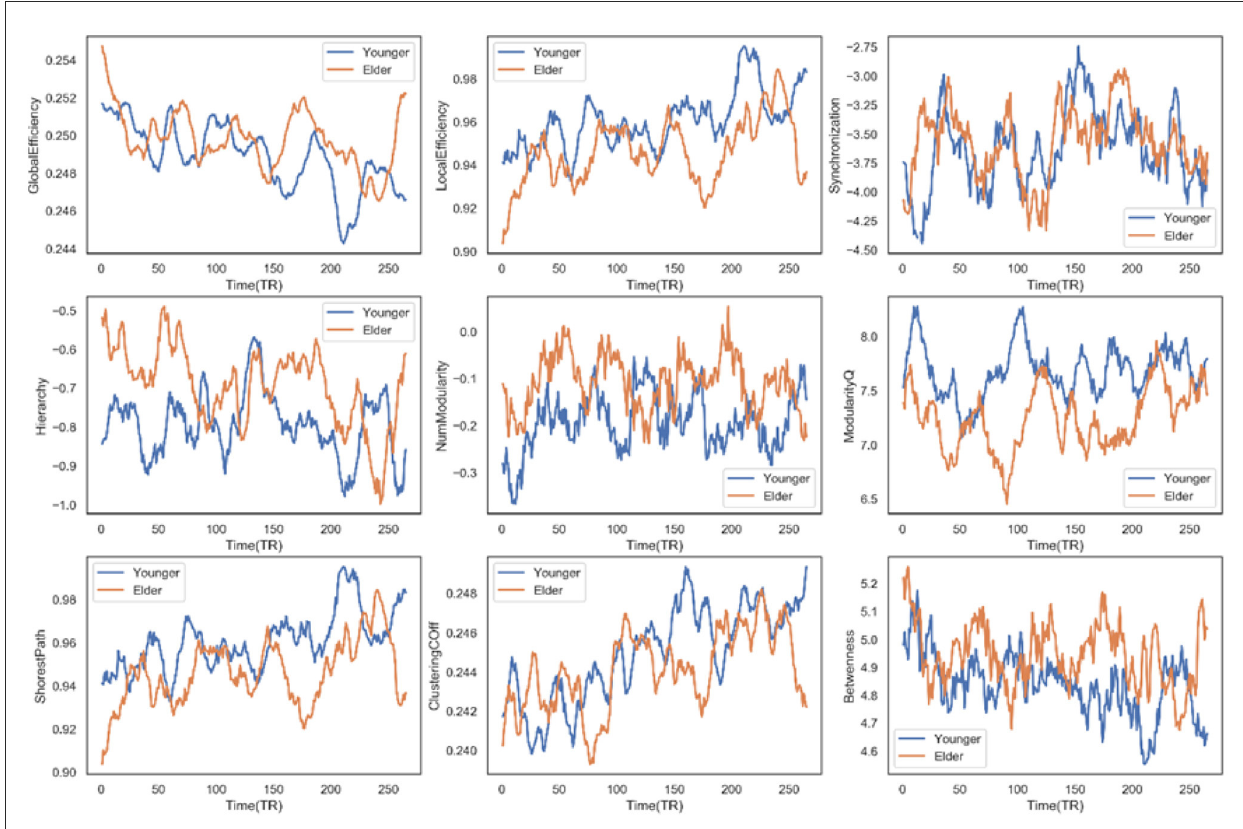
FIGURE6 Time course of multiple dynamic measures for the different age groups.